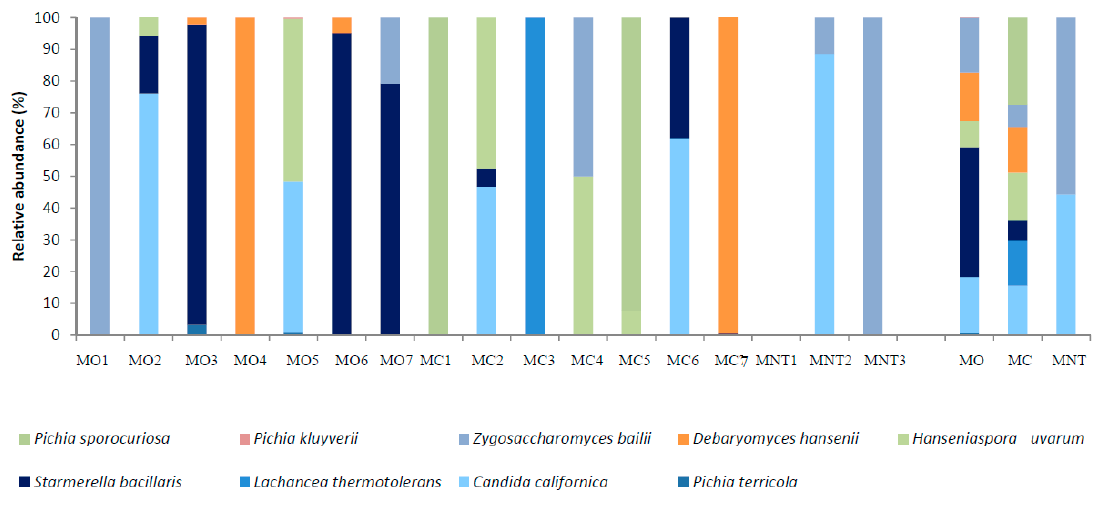
Figure 8. Principal Coordinate Analysis (PCoA) based on the fungal ITS sequences identified in organic (MO) ; conventional (MC) and not treated (MNT) samples at the harvest time (a), at 7 th day (b) and at 15 th day (c) of spontaneous fermentation. Percentages shown along the axes represent the proportion of dissimilarities captured by the axes. ( c )